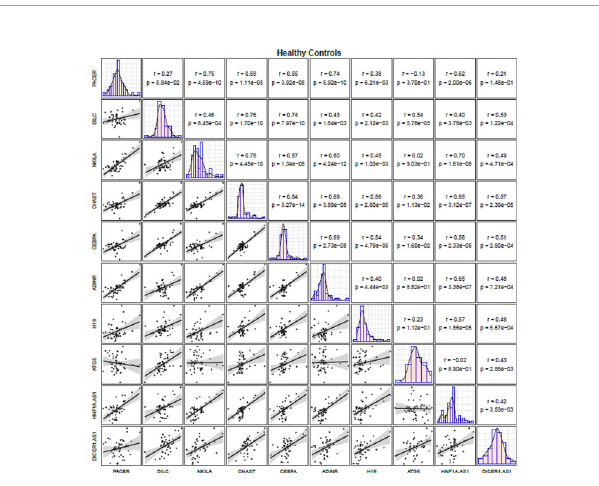
Correlation analyses among healthy controls revealed robust correlations between CHAST and CEBPA (r=0.84, P value=3.09E-09), NKILA and ADINR (r=0.80, P value=4.24E- 12) as well as between DILC and CHAST (r=0.76, P value=1.70E- 10). Figure 3 illustrates correlation matrix for healthy controls. Then, we depicted ROC curves for assessment of diagnostic power of these genes using three distinctive models with Bayesian GLM showing the best values ( Figure 4A ). Subsequently, this model was used for plotting ROC curves for all genes ( Figure 4B ).